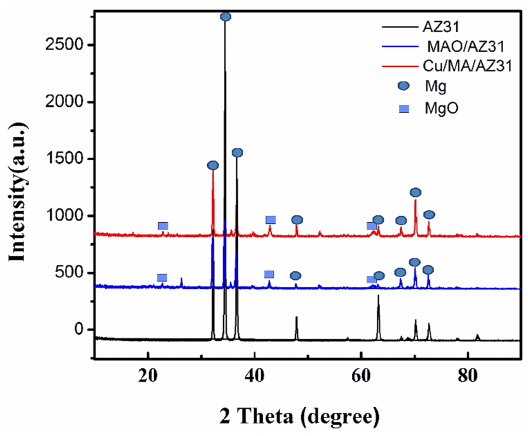
Figure 4. XRD patterns of AZ31, MAO/AZ31, and Cu/MAO/AZ31.